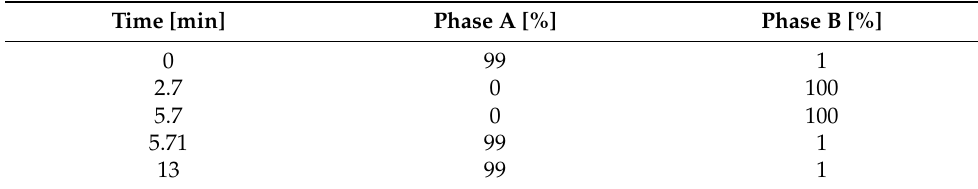
Table 2. Percentage gradient distribution of mobile phases during chromatographic separation